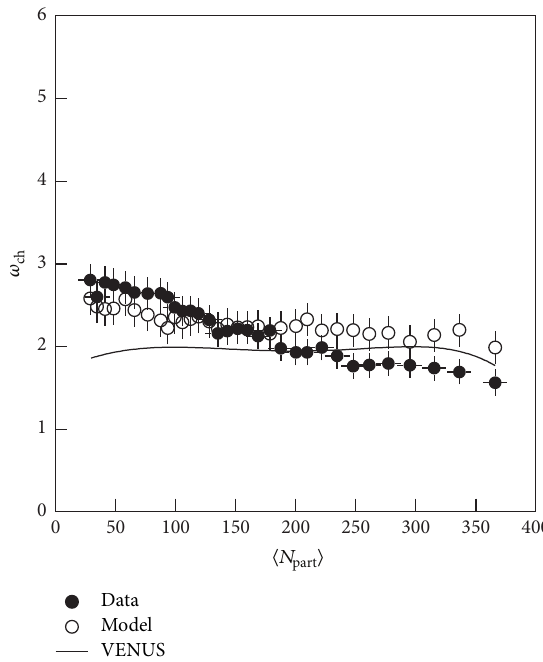
Figure 1: The relative fluctuations, 𝜔 ch , of the event-by-event measured charged particle multiplicity as a function of number of participants ( 𝑁 part ) in Pb + Pb collisions at 158 AGeV [40]. The combined (statistical and systematic) errors on 𝜔 ch from the experimental data are shown along with the data points. Details on error estimation are in [40]. The experimental data are compared to calculations from a participant model and those from VENUS event